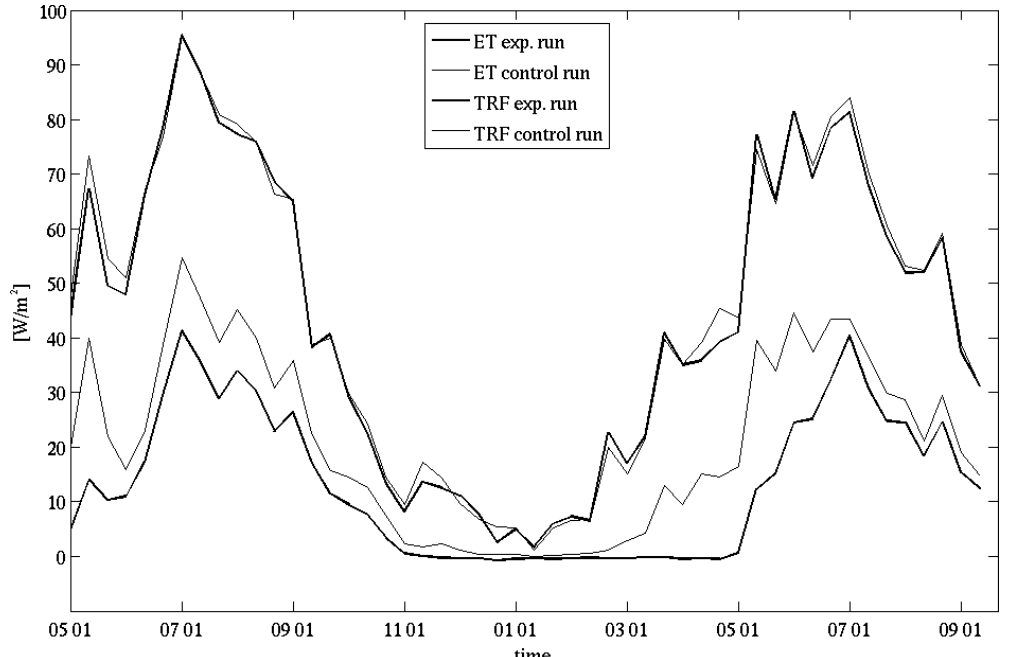
Figure 9. Evapotranspiration and transpiration fluxes (in Wm -2 ) evaluated by UTOPIA in the experimental run (thick line) and in the control run (thin line) from May 2008 to September 2009. Data are averaged in decades (three per